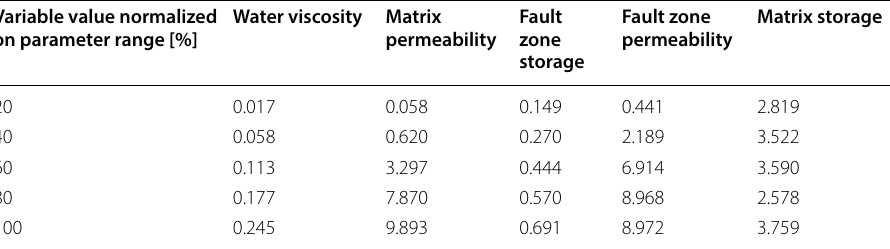
for the evenly/log-evenly spaced parameters i ,min − x i , s , F j